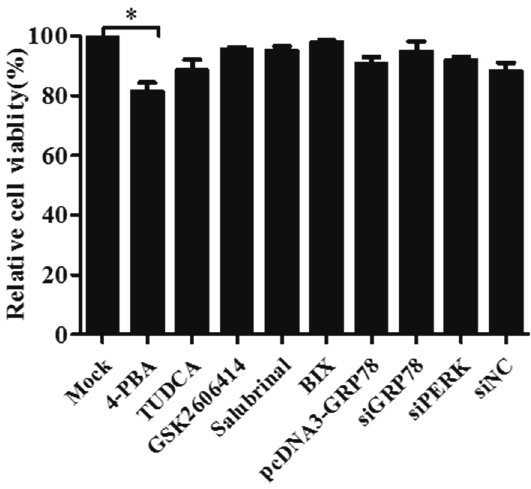
Figure 7. Pharmacological treatments or plasmid transfection and siRNA knockdown did not affect cell viability with the exception of 4-phenylbutyric acid. Cell viability was determined by CCK-8 assay after treatment of the PK-15 cells with 0.5 mg/mL TUDCA, 10 mM 4-PBA, 1 μ M GSK2606414, 50 μ M salubrinal, 10 μ M BIX or transfection with pcDNA3-GRP78, siGRP78, siPERK or scrambled RNA (siNC) for 24 h. Relative percent cell viability is expressed as means ± SEM ( n = 3).